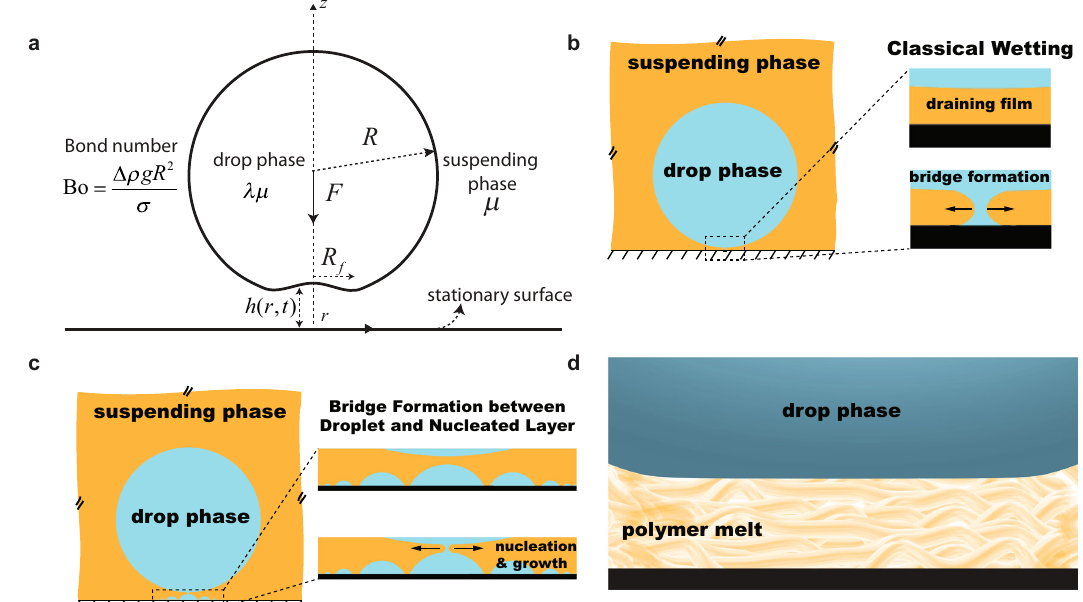
Fig. 1 The dynamics of droplet-surface interactions in the presence of an intervening fi lm of the suspending medium. a De fi nition sketch of the fi lm drainage process of one liquid in the approach of the drop of a second liquid toward a rigid, stationary surface. The Bond number Bo ¼ Δρ gR 2 = σ is the dimensionless number characterizing the gravitational force relative to the interfacial force acting on the drop. σ is the interfacial tension between the drop and suspending liquids. R f is the radius of the contact zone formed due to the trapping of a fi lm of the suspending phase between the drop and the surface. λ is the ratio of the viscosities of the drop and the suspending phases. F is the net downward external force. For a drop settling down under its own weight, the net downward force is F ¼ ð 4 = 3 Þ π R 3 Δρ g , Δρ being the density difference between the drop and suspending phase, and g being the acceleration due to gravity. b Classical spinodal dewetting theory, which involves the formation of a bridge of diameter of the order of the fi lm thickness between the wetting phase and the substrate, followed by the growth of the bridge and subsequent fi lm rupture. The right panel of sub fi gures shows a magni fi ed version of the contact zone. c The new mechanism observed in our experiments shows an alternative route, whereby diffusion of the dissolved drop fl uid through the fi lm causes nucleation and growth of islands of the drop fl uid on the surface. Here, a bridge between the approaching drop and one of the growing islands leads to the dewetting of the fi lm of suspending medium, as shown in the magni fi ed portion of the contact zone in the right panels. Note that the schematic shown is not drawn to scale. The islands are much smaller than the parent drop, and the aspect ratio depends on the island contact angle. d A sketch of the adsorption and layering of polymer chains over molecular length scales near a substrate, inspired by past experiments and simulations 13 – 22